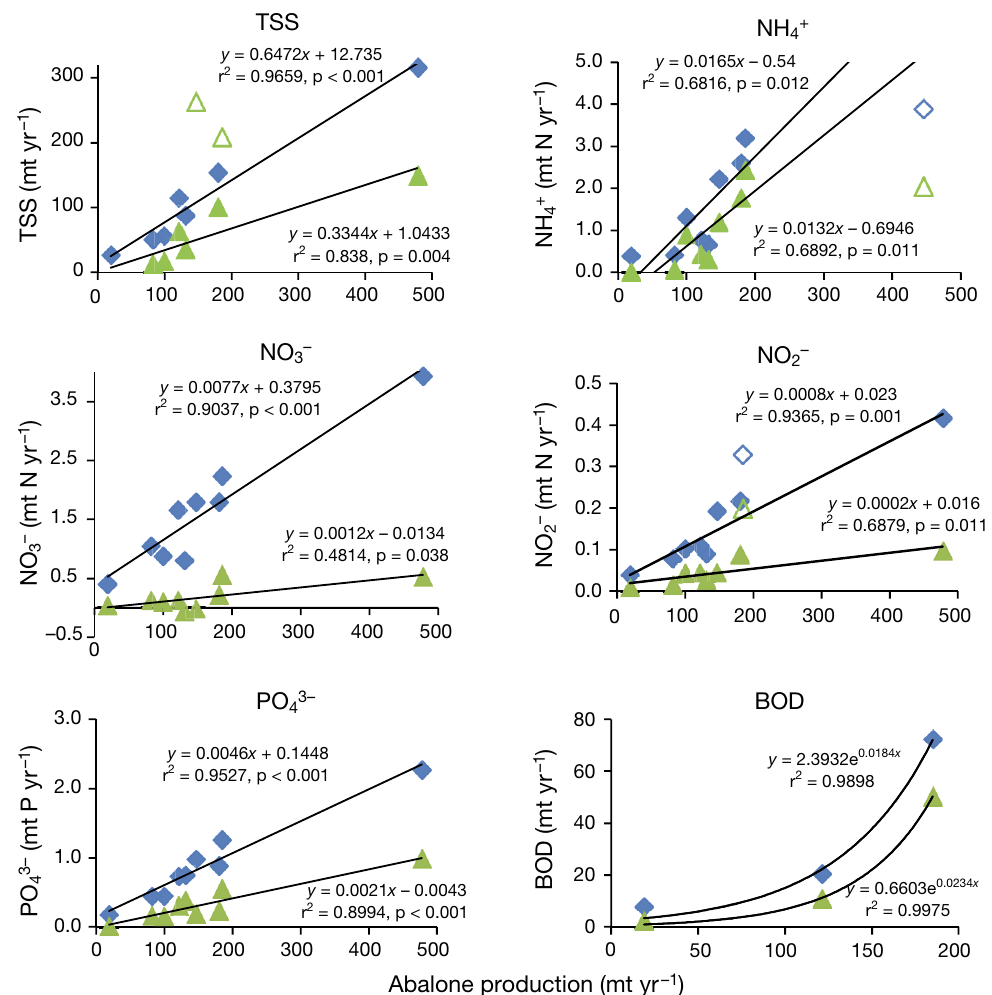
Fig. 5. Mean annual discharge rates of the various water quality variables for each farm, as related to abalone ( Haliotis midae) production. Data are presented uncorrected (blue diamonds) and corrected (green triangles) for inflow concentrations. Re- gression analyses were performed using SigmaPlot 12.0. All linear relationships were significant at the 95% level. Un-filled symbols represent data excluded from the correlations. TSS: total suspended solids, BOD: biochemical oxygen